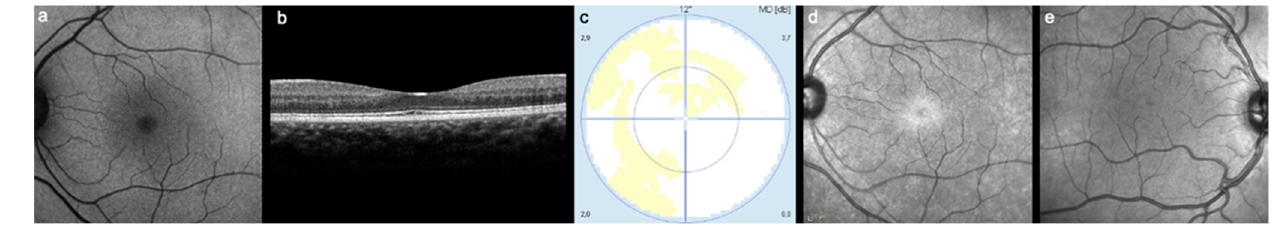
Figure 2. Case of a 40-year-old female taking a weekly dose of 2800 mg of HCQ for 36 months. The left eye shows an unremarkable ( a ) FAF, ( b ) SD-OCT and ( c ) perimetry. However, in the ( d ) NIR image ( d ), there are macular hyperreflective changes in accordance with a bull’s eye lesion. The ( e ) NIR of the right eye was normal.